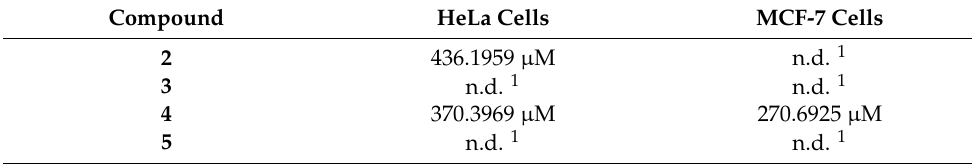
Table 1. IC 50 values calculated from dose-response curves of cell viability on HeLa and MCF7